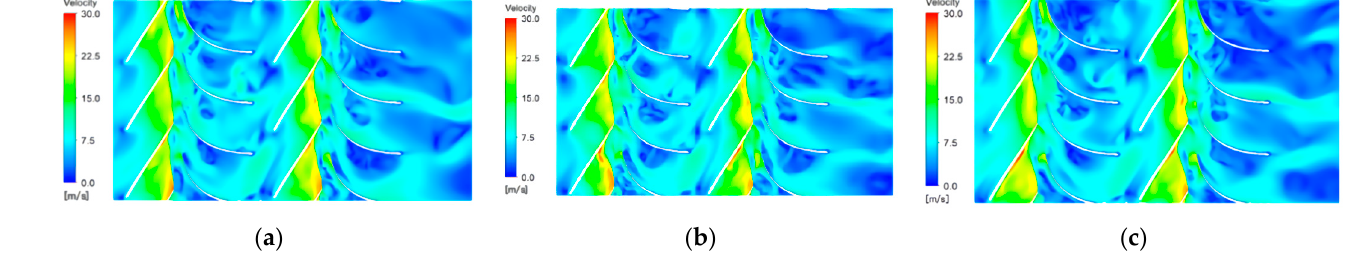
Figure 8. Velocity distribution on first-stage impeller-guide vane B2B view: ( a ) C v = 4%; ( b ) C v = 7.5%; ( c ) C v = 11.5%.